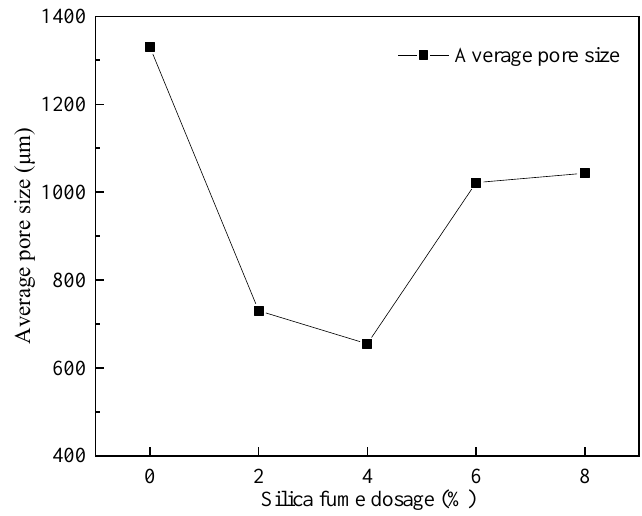
Figure 17. Effect of silica fume dosing on the average pore size.